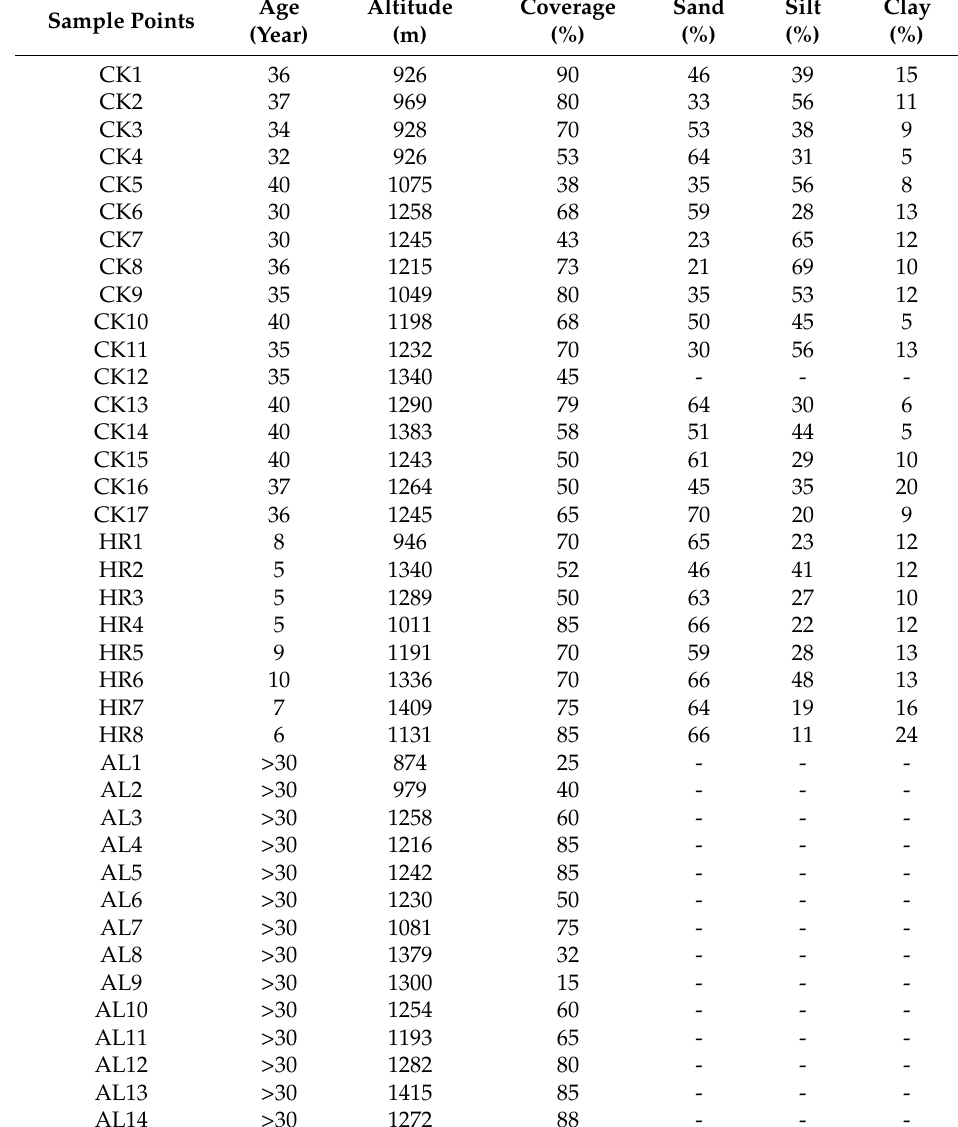
Table 1. General information of sample